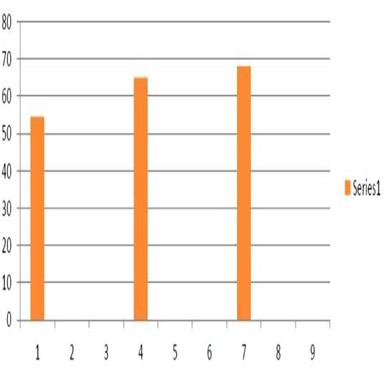
Graph of microhardness value of three samples.